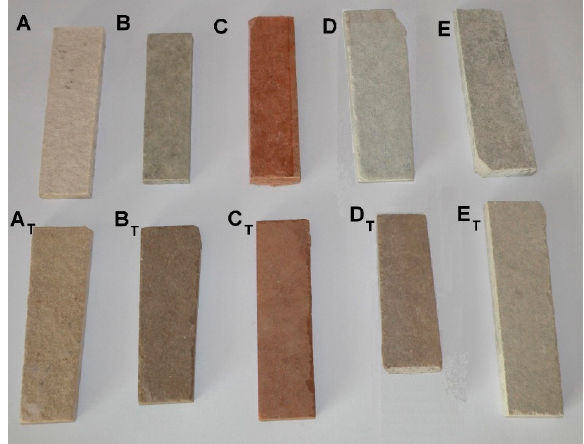
Figure 2. View of the small FCB (fiber cement board) pieces used for microscopic observation. Upper row: specimens of FCB types A, B, C, D and E before the elevated temperature treatment. Lower row: specimens of FCB types A, B, C, D and E after the elevated temperature treatment.